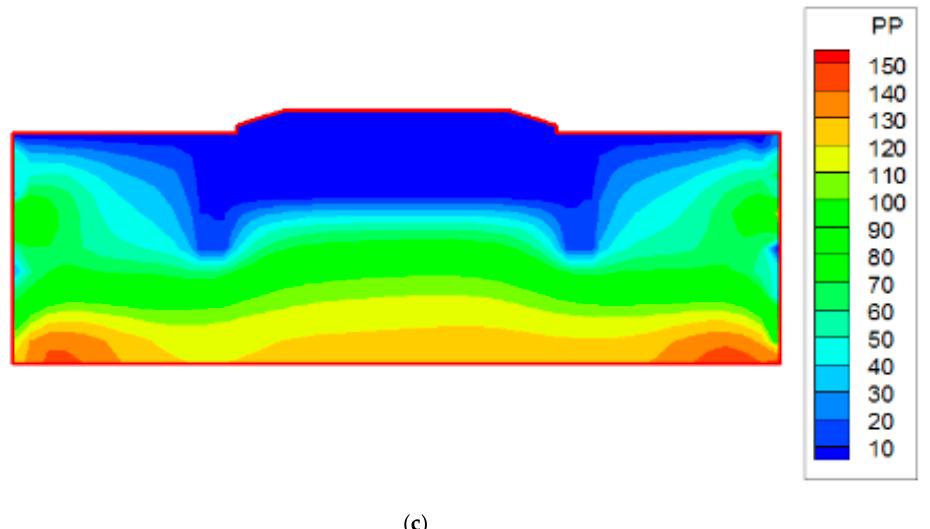
Figure 9. Contours of dynamic excess pore water pressure at 20 s in natural foundation and rein- forced foundations. ( a ) Natural foundation. ( b ) Foundation reinforced with isometric gravel piles. ( c ) Foundation reinforced with subarea long-short gravel piles.